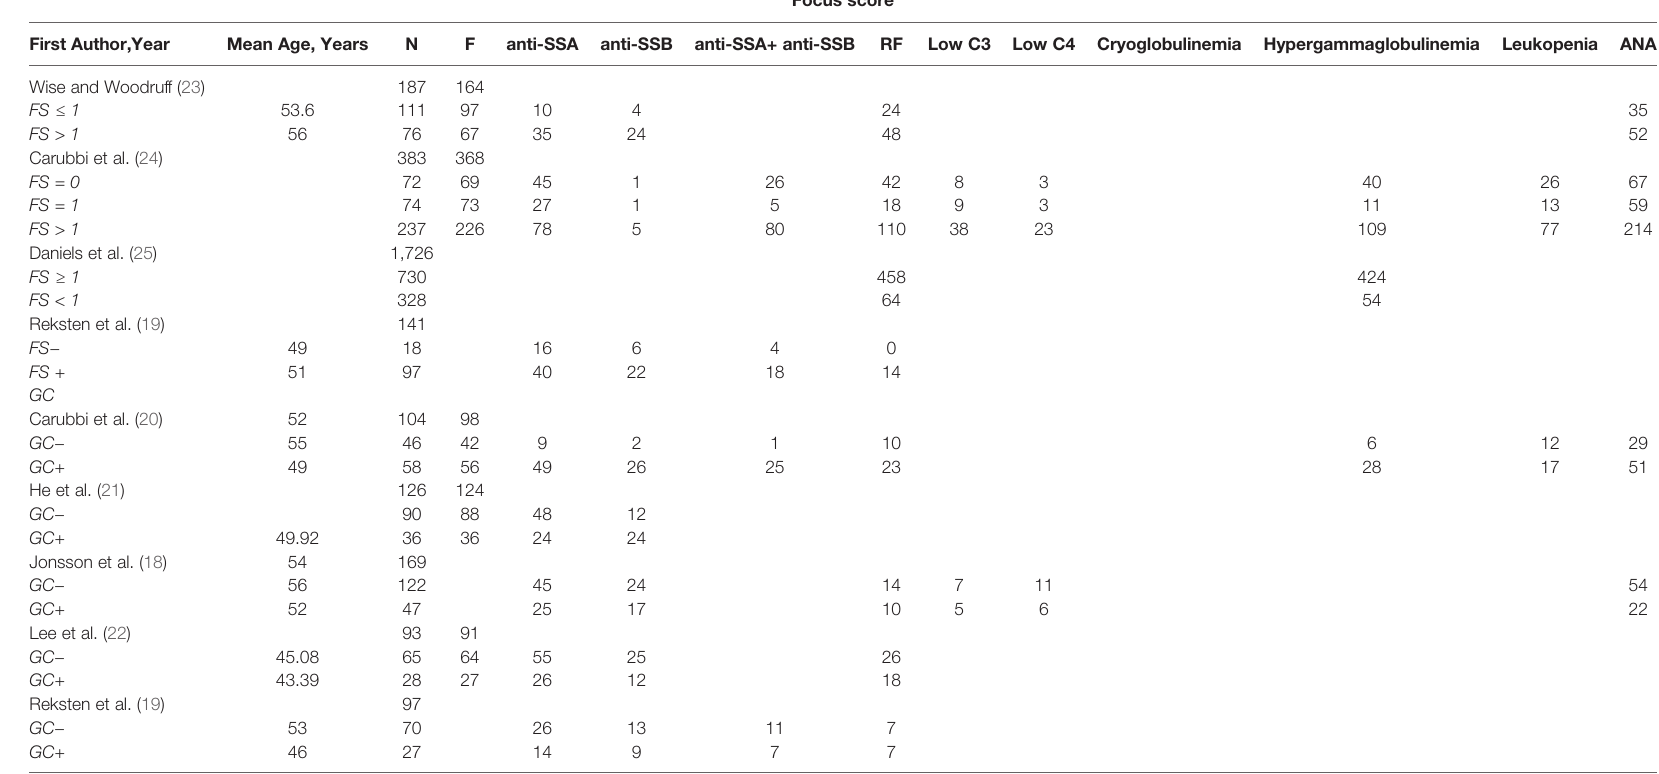
TABLE 4 | Main serological characteristics of patients in selected